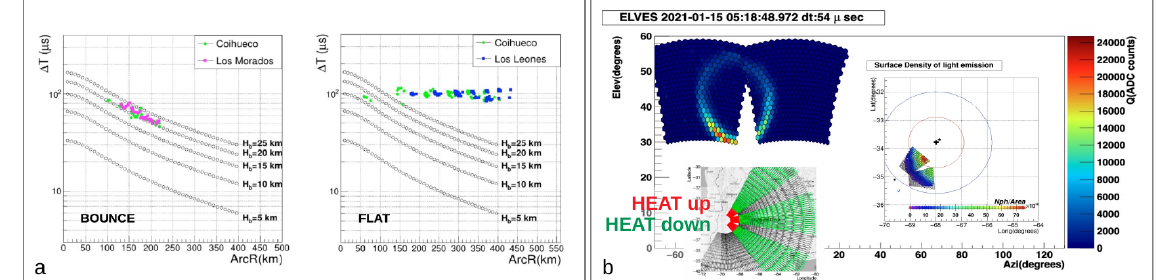
Figure 2. Panel “a” : classification of double ELVES according to the time gap between the two pulses vs arc distance, which is the distance on the emission layer between the projection of the position of the lightning triggering the ELVES and the region where the EMP is converted into the UV light which we observe in a given pixel of our camera. Panel “b” : bottom left - projection of each camera pixel at the base of the ionosphere for HEAT telescopes in their configuration “up” and “down”. In the configuration “up”, it is possible to observe ELVES closer to the Observatory; top left - an ELVES ring shape in the HEAT camera; right - ELVES light density at the emission